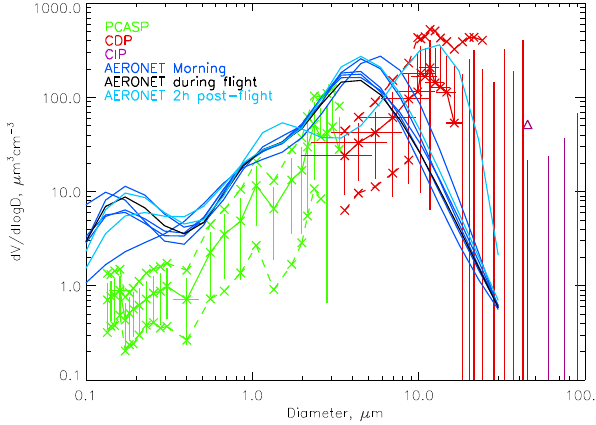
Figure 11. Volume size distributions from BAe146 flight b611 Pro- file 1 (15:58 to 16:27UTC) compared to AERONET retrievals. Air- craft size distribution measurements are shown by green (PCASP), red (CDP) and purple (CIP15). Solid lines show the median vol- ume concentrations over the column up to 5.5km. Vertical error bars show standard deviation over the column (where lower error bars reach below the plot minimum, they have been omitted for clarity). Horizontal error bars show uncertainties in bin size. Points with dashed lines represent the 10th and 90th percentiles across the column. AERONET retrievals from the Zouerate site over the day are shown in dark blue (morning), black (retrieved during the flight) and light blue (retrieved shortly after the